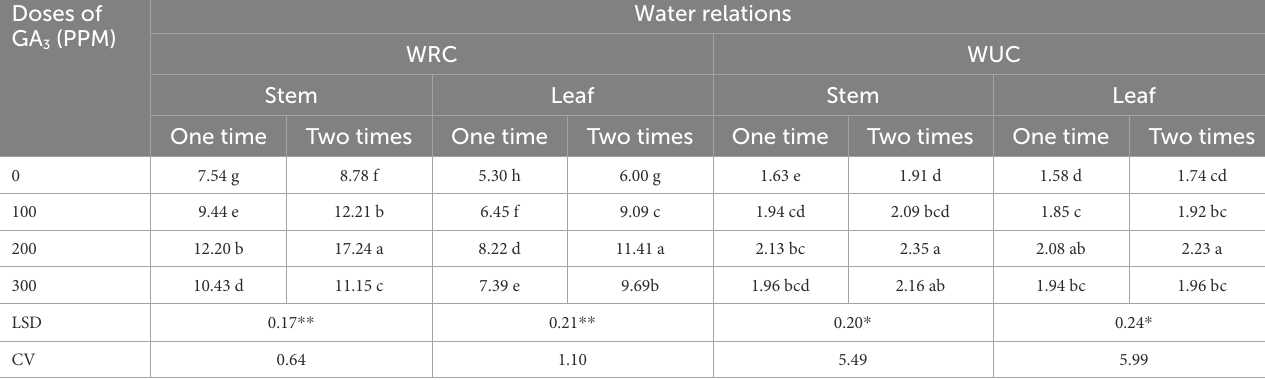
Water relations